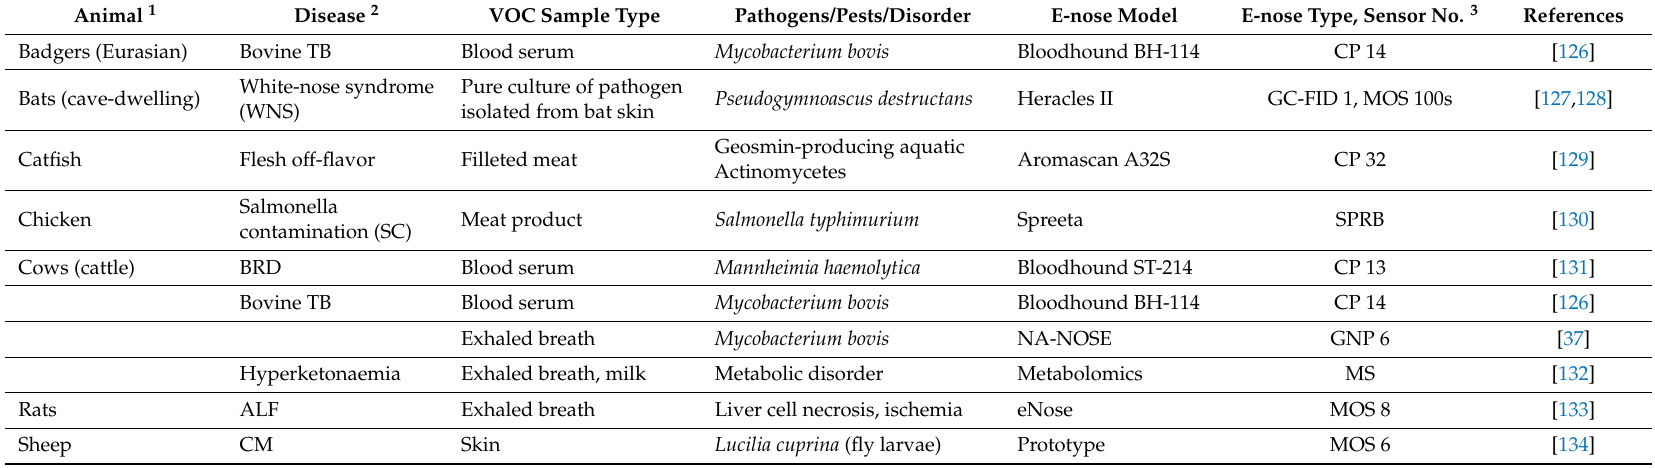
Table 3. Applications of electronic-nose devices used in veterinary diagnostic pathology to detect animal